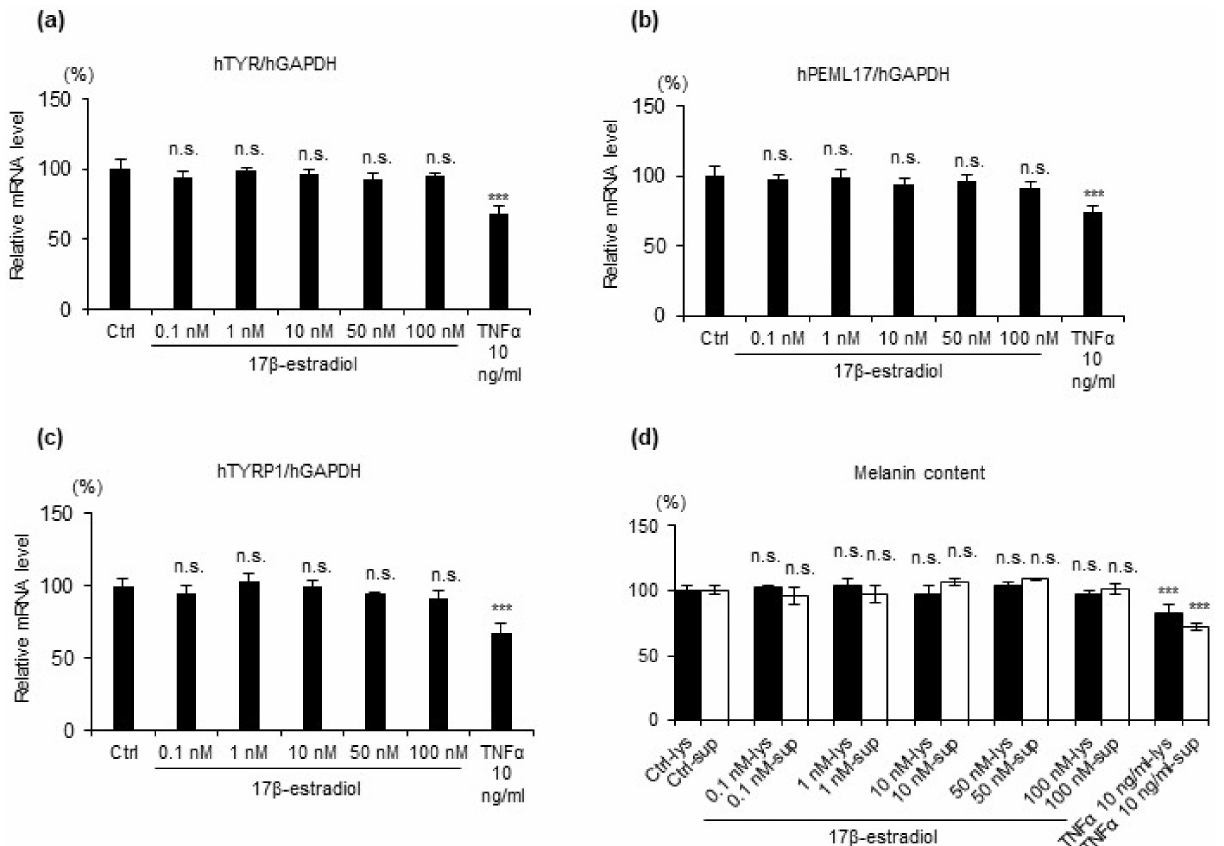
Figure 3. mRNA expression level of melanin synthesis-related genes and melanin content in cell lysates and culture medium after treatment with 17 β -estradiol. Relative hTYR ( a ), hPMEL17 ( b ), and hTYRP1 ( c ) gene expression in cultured human epidermal melanocytes after 24 h exposure to the indicated treatments. ( b ) Melanin content quantification by melanin content assay in a culture medium; ( d ) melanin content quantification by melanin content assay in cell lysates and culture medium after 7 days exposure to the indicated treatments. Data represent the results of three independent experiments. Data are shown as means ± SD. *** p < 0.01; n.s., no significant